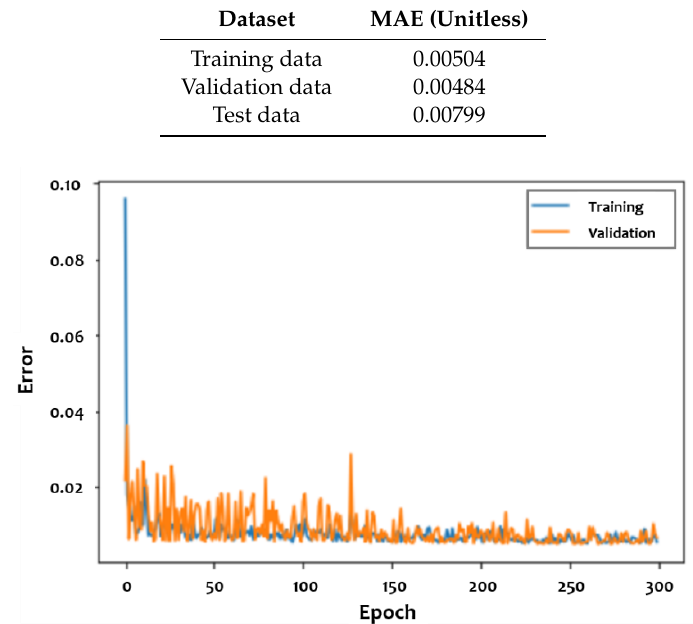
Energies 2020 , 13 , x FOR PEER REVIEW Figure 11. Error functions for the RNN-LSTM training in Process 2. Figure 11. Error functions for the RNN-LSTM training in Process 2. Table 3. Error functions for Process 2.